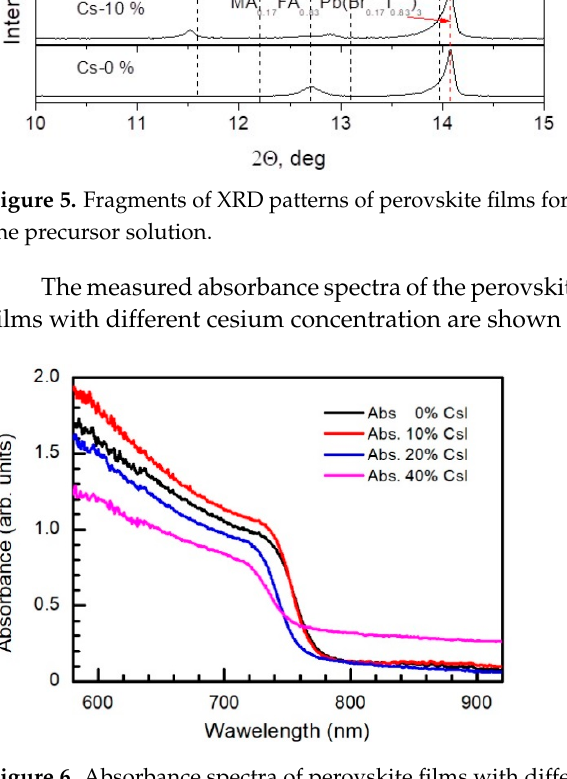
Figure 6. Absorbance spectra of perovskite films with different Cs concentration.